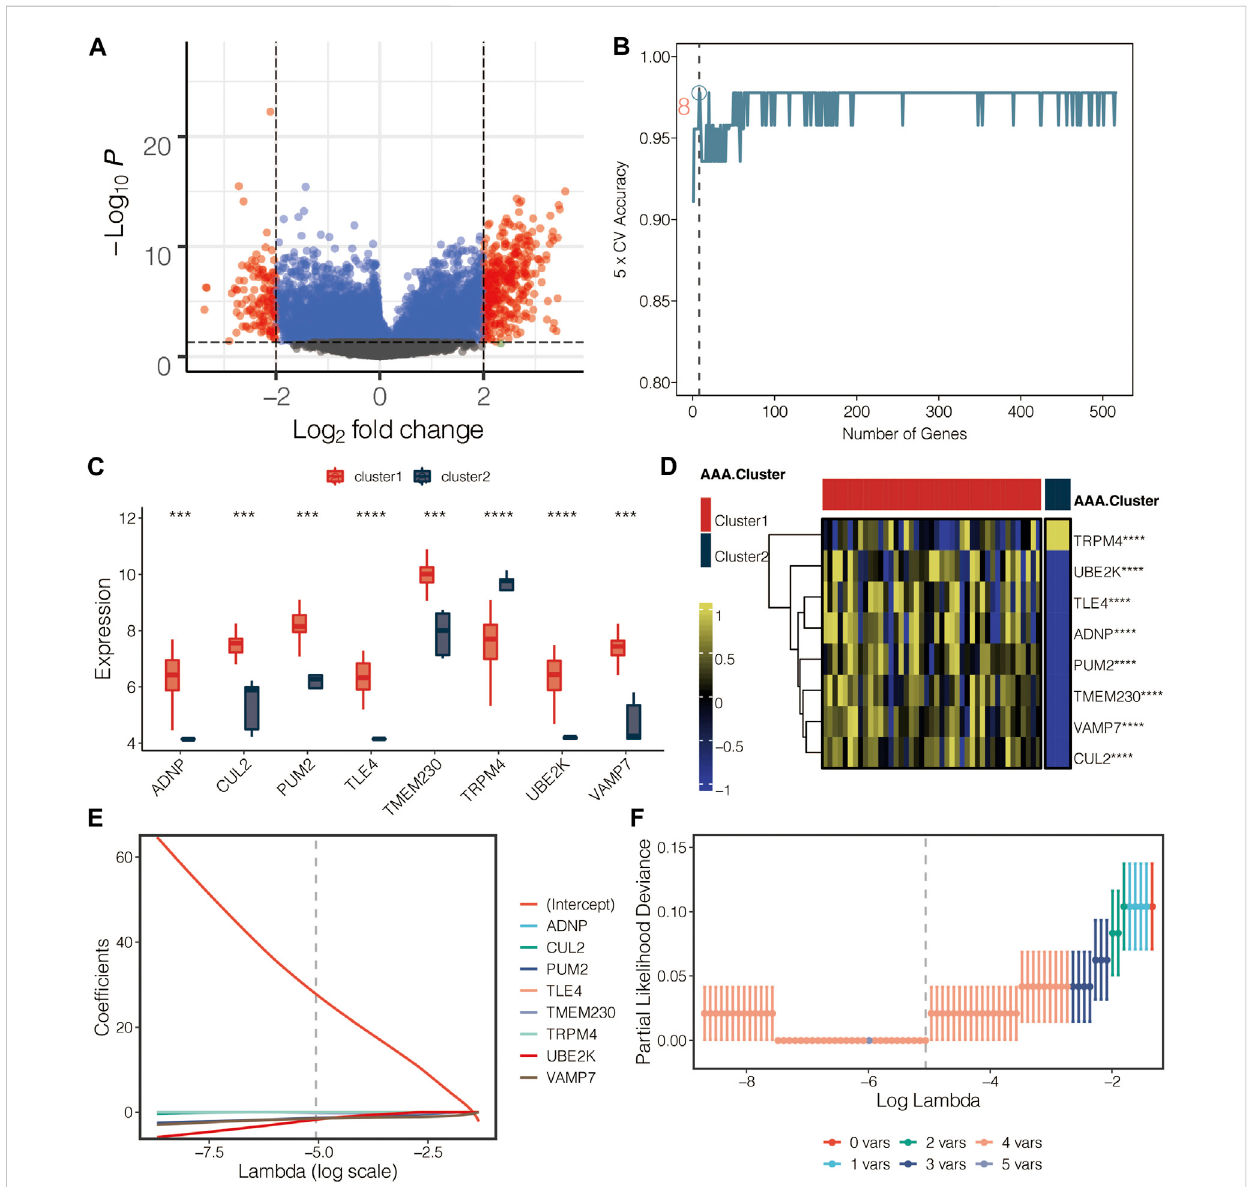
FIGURE 6 Development of the AAA-related score. (A) Volcano plot for the limma-based DEGs between the AAA-related clusters in GSE98278. (B) Random forest for dimension reduction of the limma-based DEGs between the AAA-related clusters in GSE98278. (C) Box plot for the eight limma-based DEGs between the AAA-related clusters in GSE98278. (D) Heatmap for the eight limma-based DEGs between the AAA-related clusters in GSE98278. (E) Coef fi cients in LASSO regression analysis in GSE98278. (F) Partial likelihood deviance in LASSO regression analysis in